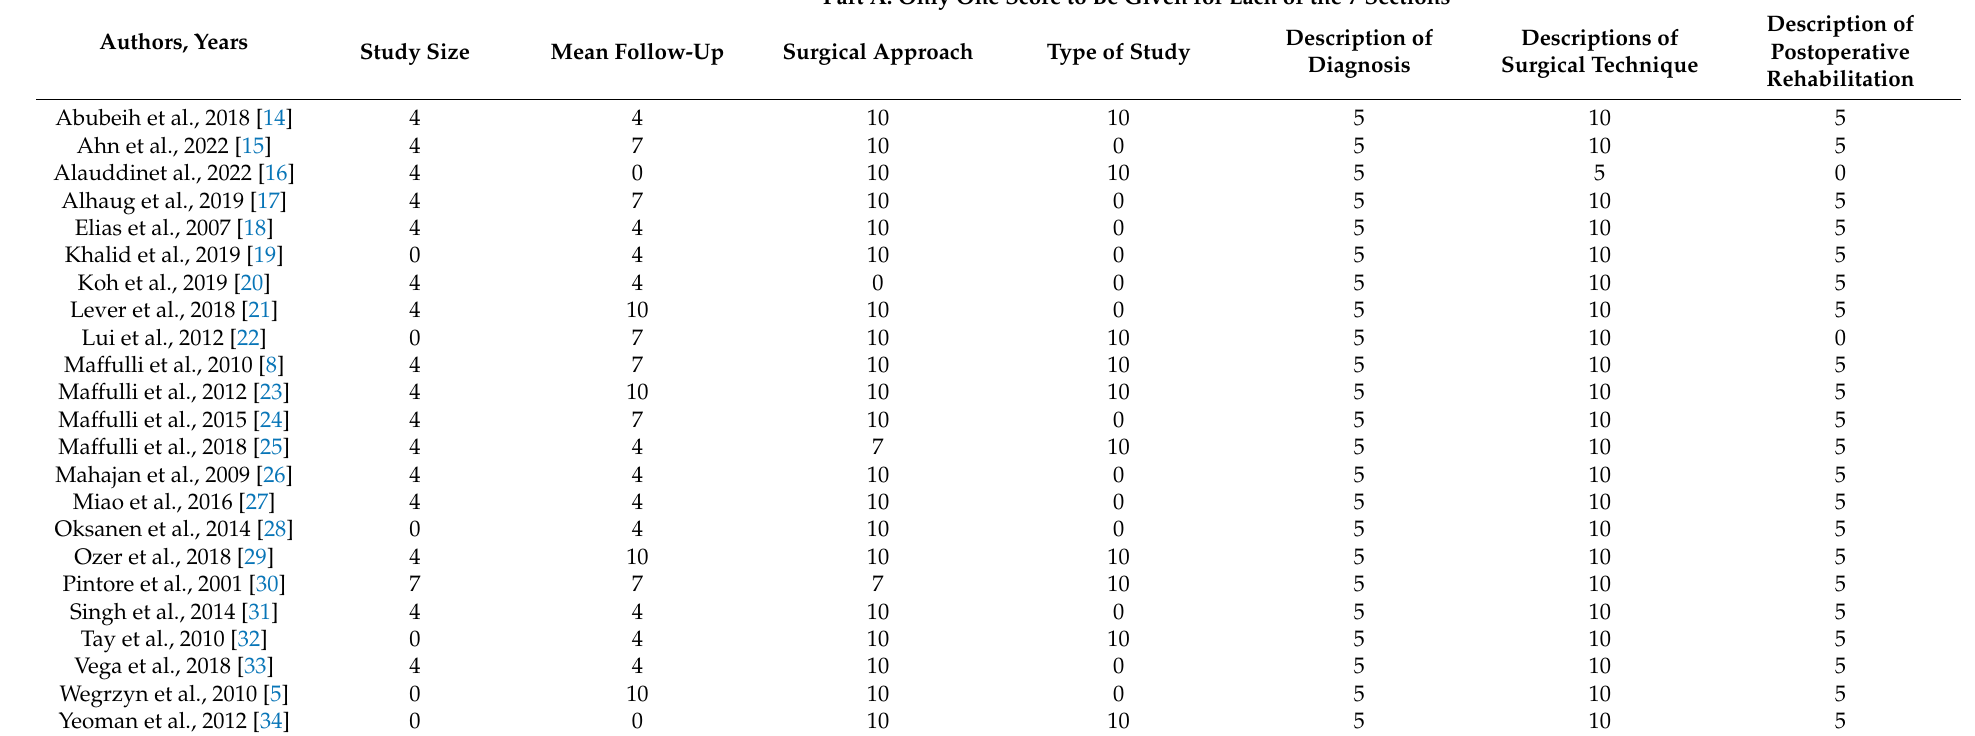
Table 1. Methodological Quality Assessment: Coleman Methodological